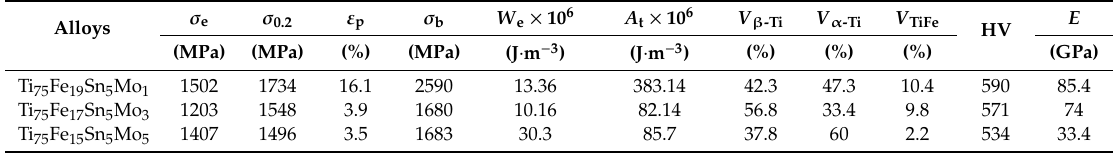
Table 1. Mechanical properties of Ti–Fe–Sn–Mo alloys, including linear elastic limit ( σ e ), the 0.2% o ff